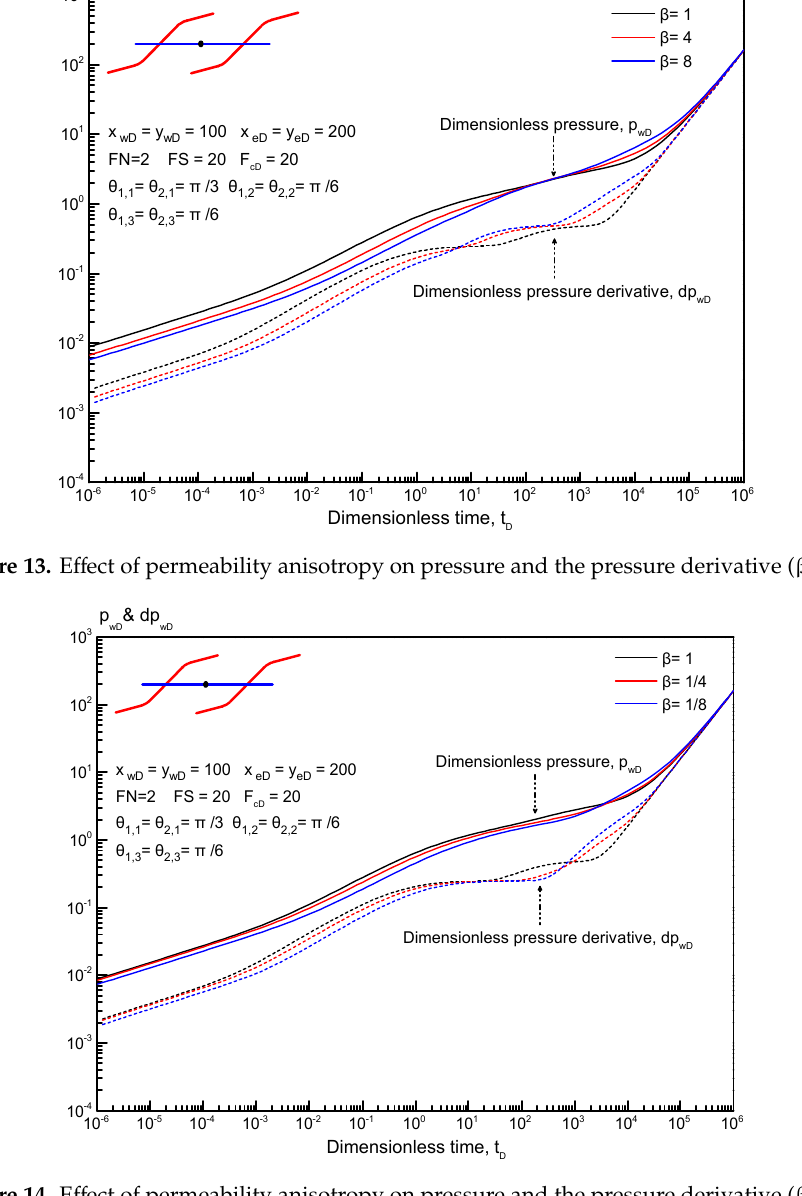
ff ect of permeability anisotropy on pressure and the pressure derivative ( β ≤ Figure 14. Effect of permeability anisotropy on pressure and the pressure derivative ( β ≤ 1). Figure 14. E